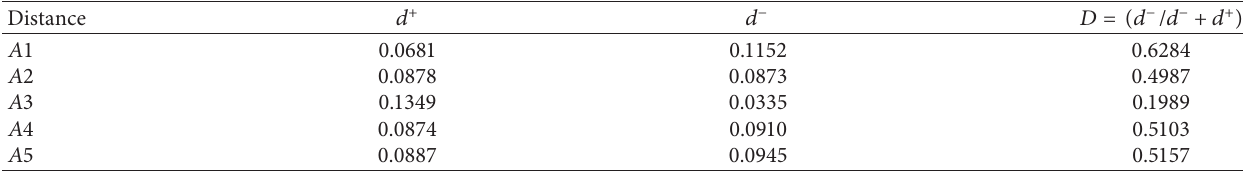
Table 3: The distance from each scheme to the ideal solution. Distance d